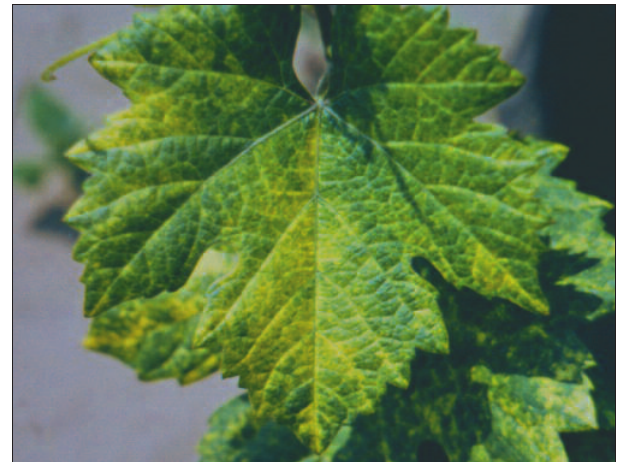
Figure 5 . Chrome mosaic (GCMV) - symptoms in Vitis vinifera cv. Szerémi zöld: leaves partially or entirely bright yellows or whitish